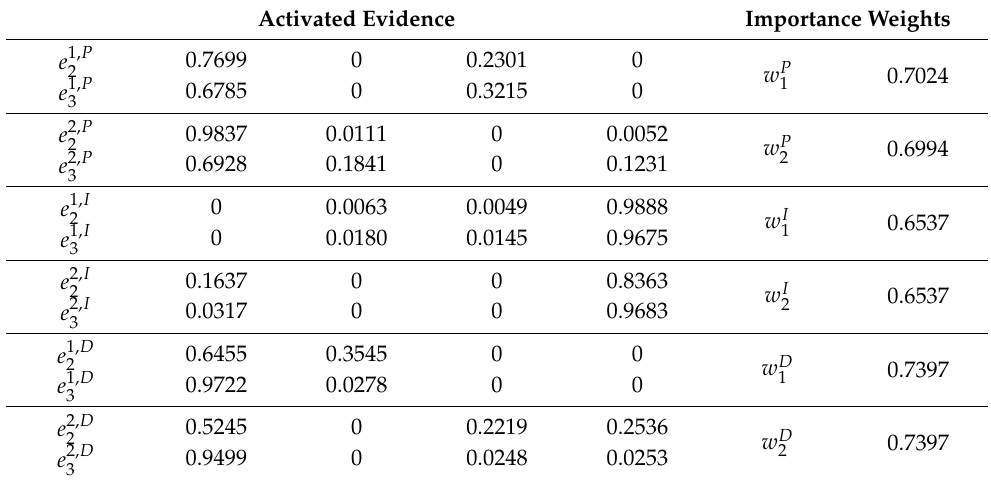
Table 11. Evidence activated at time k = 3 and their corresponding importance weights after optimization.